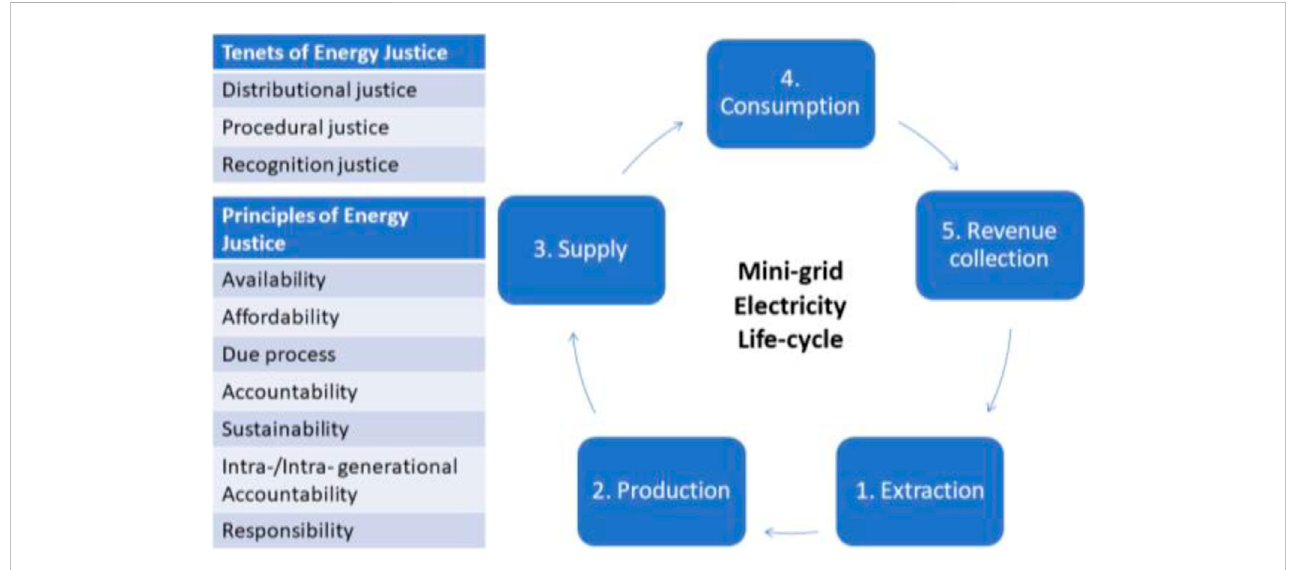
FIGURE 6 The energy justice framework applied to mini-grid electricity life-cycle (Villavicencio Calzadilla and Mauger,